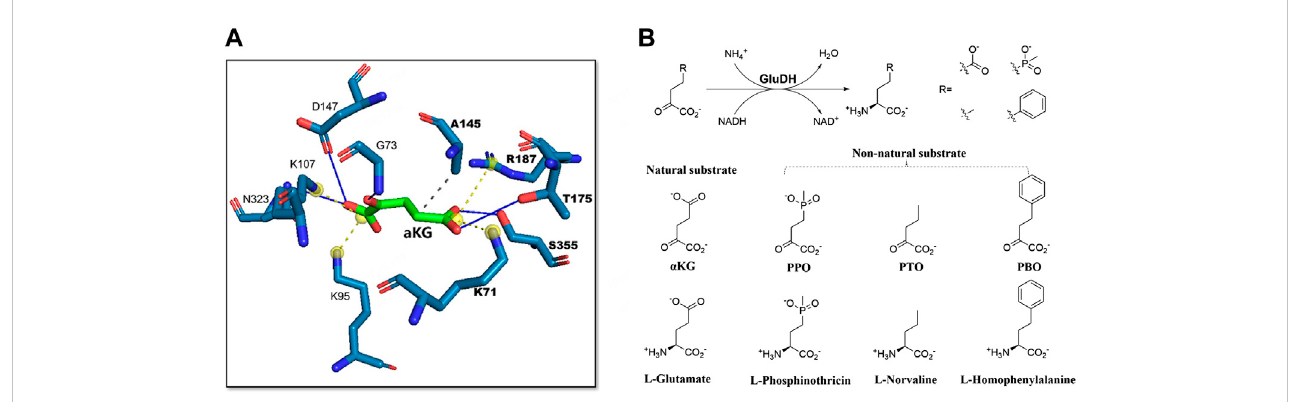
FIGURE 3 Engineering of glutamate dehydrogenase for accepting non-natural substrates. (A) , Salt bridges formed between γ -carboxyl group of the natural substrate α KG and two residues K71, R187. (B) , The natural and non-natural substrates of GluDH and the corresponding products. Reprinted with permission from (Wang Z. et al., 2022). Copyright 2022, American Chemical